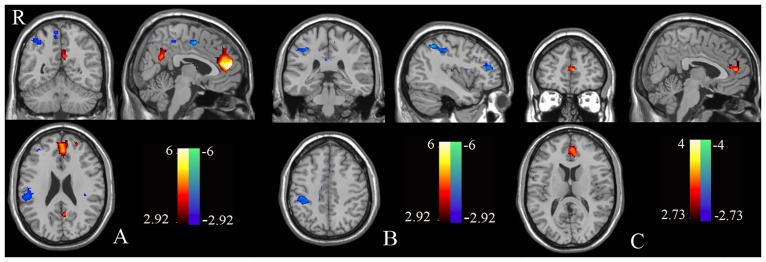
Brain regions showing self-semantic activation in patients with schizophrenia and the control group.One-sample tests produced the spatial patterns of brain regions showing self-semantic activation for both healthy controls (A) and patients with schizophrenia (B). Warm colors represent positive while cool colors indicate negative activation. A two-sample t-test assessed the differences between the two groups (controls versus patients, C). The above results were obtained with threshold p < 0.01, AlphaSim correction p< 0.01.